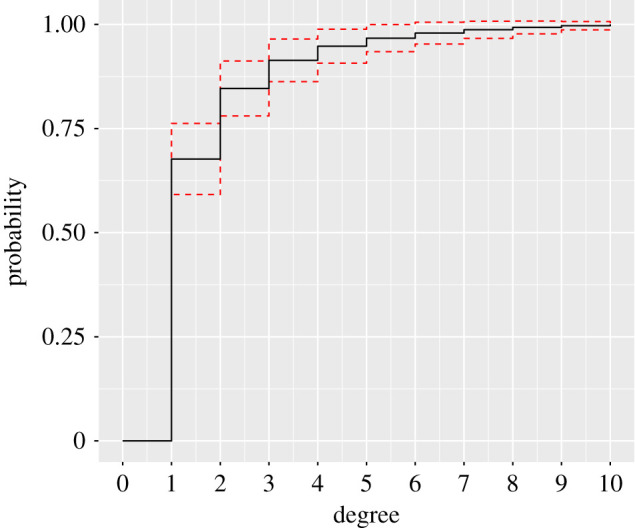
An example of a de Solla Price cumulative degree distribution; dashed lines indicate the standard deviation of the empirical degree distribution considering a network of size 30. (Online version in colour.)